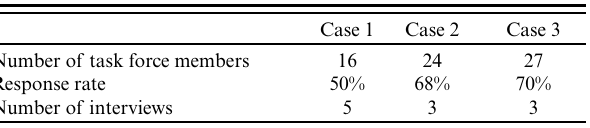
Table 2 . Number of task force members surveyed and interviewed and response rate by